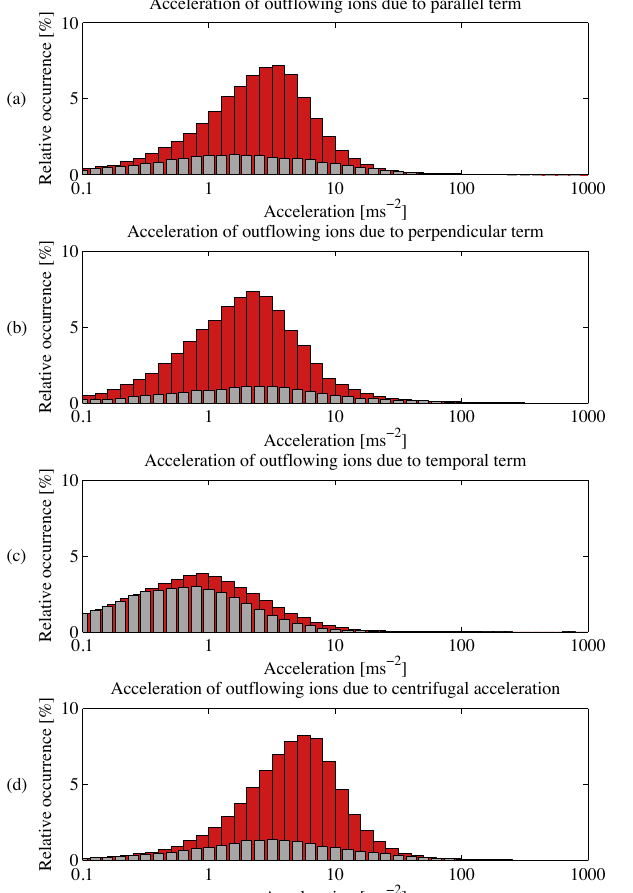
Fig. 1. Distribution of the centrifugal acceleration for all valid measurement points. The x-axis shows the acceleration [ms − 2 ], the y-axis shows the relative occurrence [%] for positive (increased outflow velocity, red bars) and negative acceleration (decreased out- flow velocity, light grey bars). The light grey bars are shifted half a bin towards lower values to increase readability. Panel (a) shows the parallel term, (b) the perpendicular term, (c) the temporal term of Eq. (3). Panel (d) shows the sum of all terms.